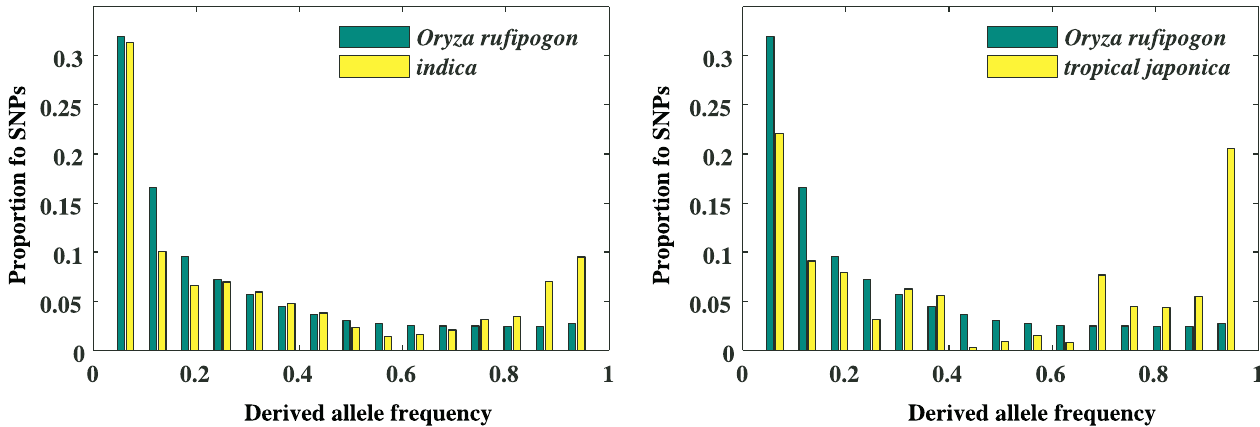
Figure 2. The Observed Marginal Derived Site-Frequency Spectra of Noncoding and Synonymous SNPs for Two Population Pairs: indica and O . rufipogon and tropical japonica and O . rufipogon To accommodate SNPs with missing data, all spectra are plotted as the expected site frequency spectrum in a subsample of the data of size n ¼ 16.